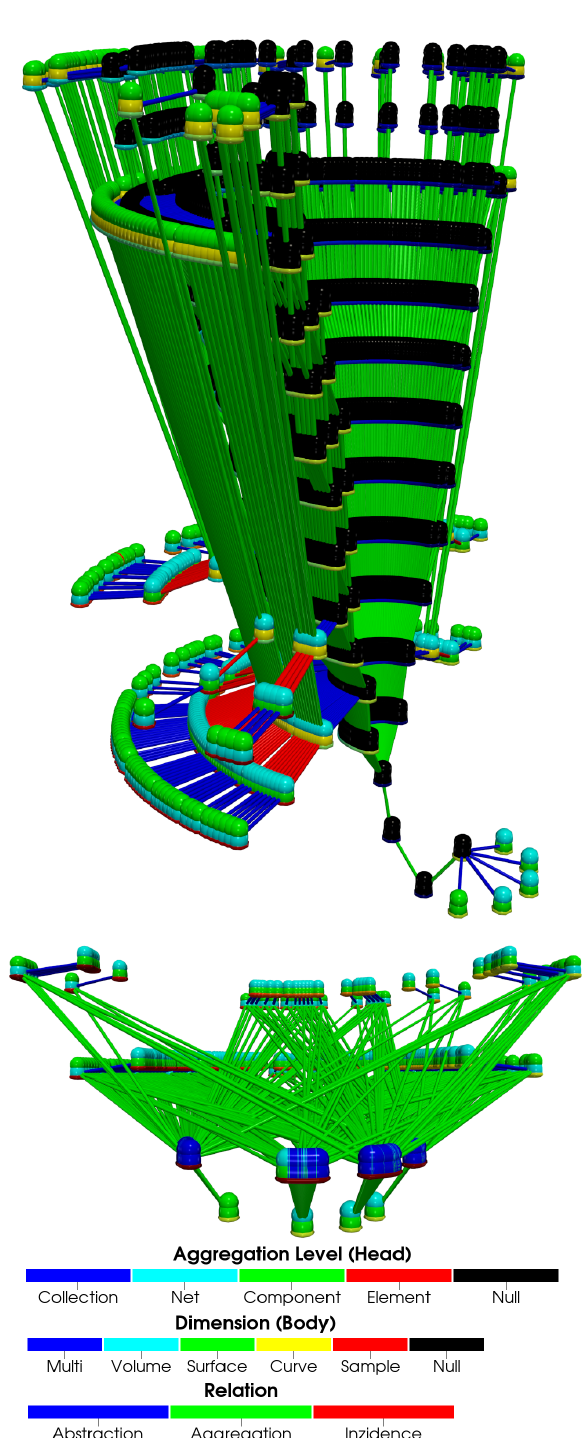
Figure 9. Topology of the geometries shown in Figure 8. Top: CityGML tree (black) with polygons as BREPs (green head, yellow body), grouped by BuildingPart/Building -Tag (cyan head, yellow body), triangulated (cyan head, green body), tetrahedralized (green head, cyan body) together with the DTM (green head, green body) and the four water surface nets (cyan head, green body). Bottom: DTM and the three water surface nets, which intersect the tetrahedralized CityGML. Intersection-nodes are part-of two nodes,